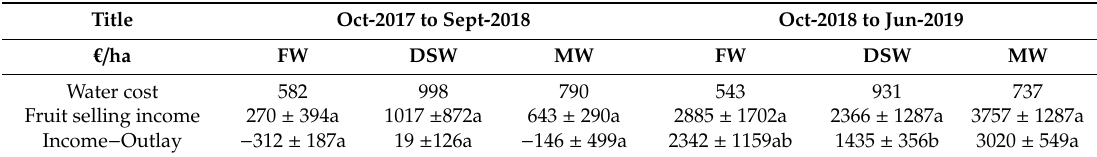
Table 5. Economic assessment of the mandarin production under the three scenarios selected. For each year and row, means with the same letter are not significantly di ff erent according to Tukey’s HSD test (P ≤